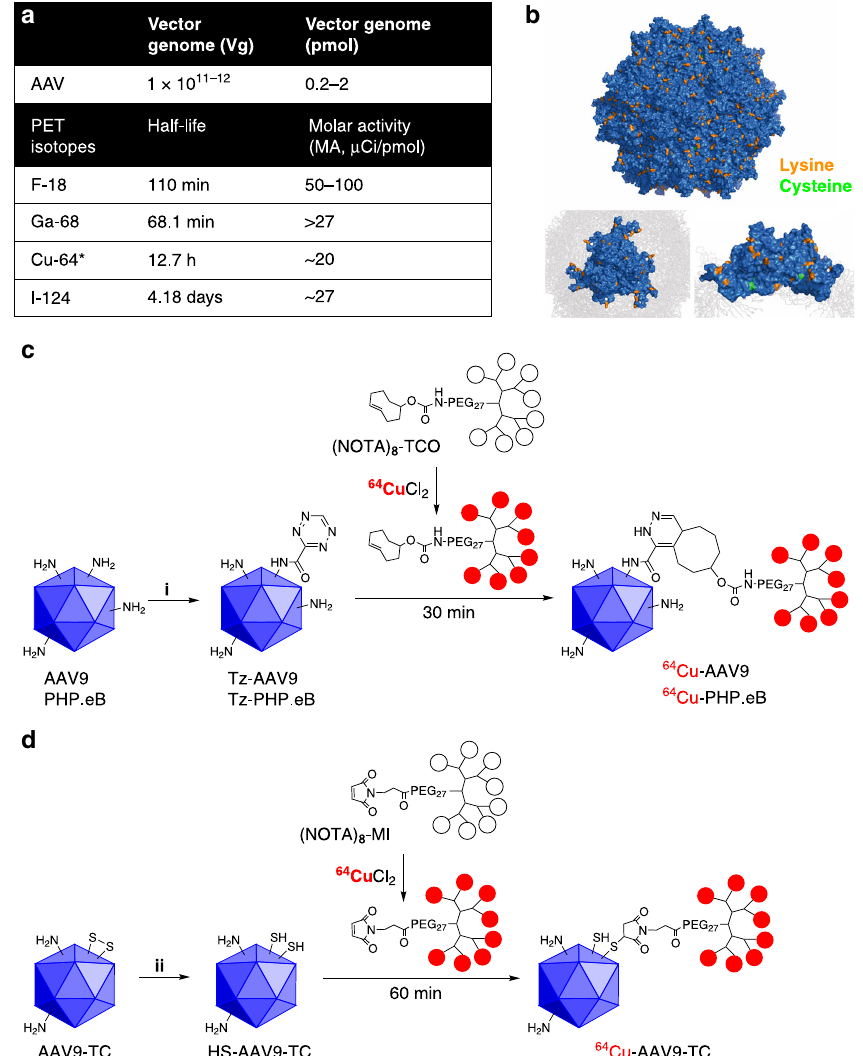
Fig. 1 Strategy for labeling AAVs with a positron emitter. a Table presents the number of AAVs systemically injected and the molar activity of positron emitters. b Solvent accessible surface of AAV9 capsid 30 (PDB ID:3UX1) displayed by PyMOL software. Insets highlight a trimer around a threefold axis. Orange and green color represent lysine and cysteine residues, respectively. Solvent radius is set as 1.4 angstrom. AAV capsid is composed of 60 structurally identical viral protein subunits (VPs) with 1:1:10 ratio of VP1:VP2:VP3. c , d are the labeling schemes of AAV-PHP.eB, AAV9, and AAV9-TC. c Surface modi fi cation with multichelators (MC) on lysine residues in capsids. (NOTA) 8 -TCO (incorporating a PEG 27 spacer) is employed for the radiolabeling of Tz-AAV9 or Tz-PHP.eB after reaction of Tz-NHS ester with AAV9 or PHP.eB. (i, tetrazine-PEG 5 -NHS (Tz-NHS) ester, 1x PBS (pH 8), 4 °C, overnight dialysis in 20 kDa molecular weight cut-off (MWCO) membrane). d The site-speci fi c radiolabeling on cysteine residues in AAV9-TC was employed with the multichelator-maleimide conjugate ((NOTA) 8 -MI) incorporating Cu-64 after the reduction of tetracysteine with TCEP (ii, TCEP in 1x PBS (pH 7.0 – 7.5)). Asterisk indicates average molar radioactivity of Cu-64 from commercial vendor as used in this